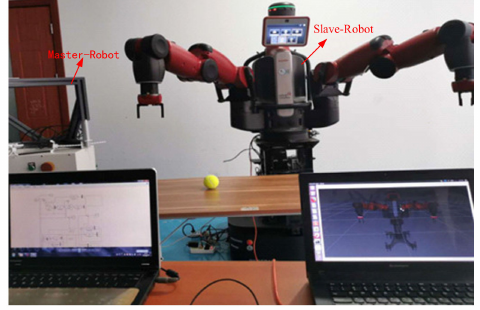
Figure 20. Experimental scene.